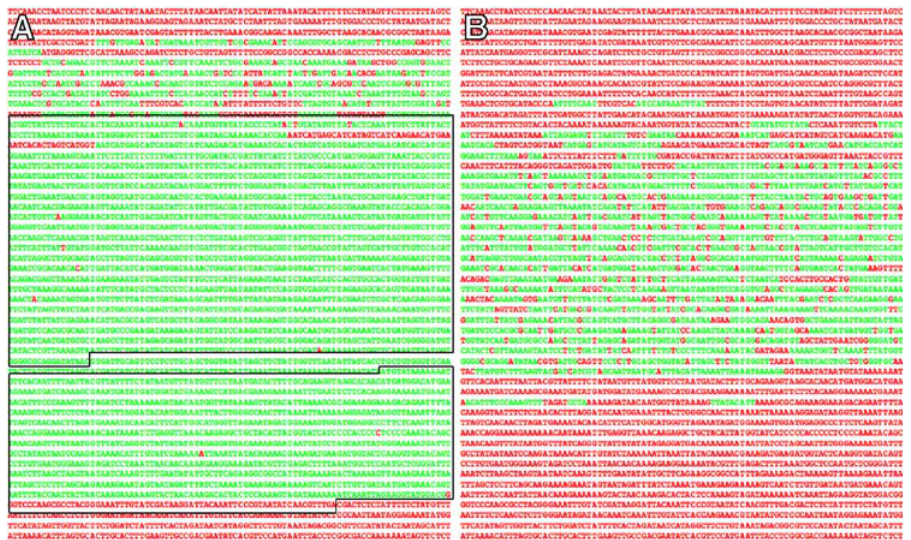
Figure 3. S.aureus MRSA252 and Listeriamonocytogenes chromosomes share near identical copper ATPase transporter and copper oxidase genes. A ) Shown is a Listeria monocytogenes DNA (4,680 bp) – MRSA252 pairwise enhanced BLAT ( e BLAT) DNA alignment revealing near sequence identity that spans the ORFs for the copper ATPase transporter (SAR0720; upper box) and the copper oxidase genes (SAR0721; lower box) [23]. The Listeria genomic region of this e BLAT (GenBank accession AARR00000000), used as the reference sequence, was selected as ‘other species’ in the sequence input page of EvoPrinter . Use of this feature allows for the comparative analysis of any sequence with respect to the genomes in the EvoPrinter database. Red-colored letters indicate unique bases that not shared with MRSA252. Green-colored sequences are common to both Listeria and MRSA252. B ) Listeria DNA (same sequence as in panel A ) e BLAT alignment with the S. aureus USA300 genome identifies CopA (SAUSA300_0078) but with a significantly lower sequence homology when compared to the MRSA252 DNA ( A